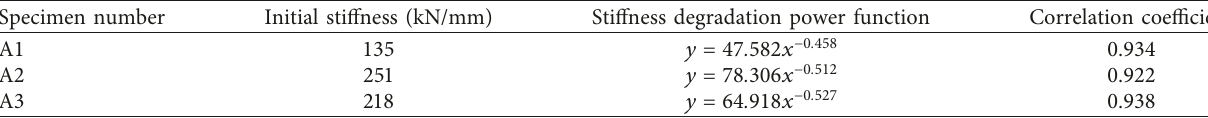
Figure 14: Degradation curves for all wall stiffnesses: (a) A1, (b) A2, and (c) A3. Table 4: Stiffness-displacement quasi-curve.